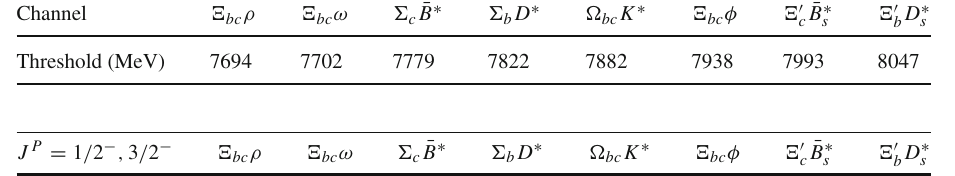
various channels and g i G II MeV with q max = 650MeV